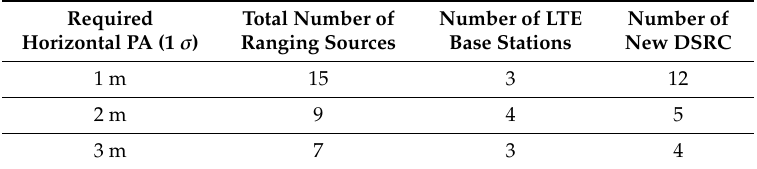
Table 1. The number of ranging sources of LTE and DSRC that meets the required positioning accuracy (PA).